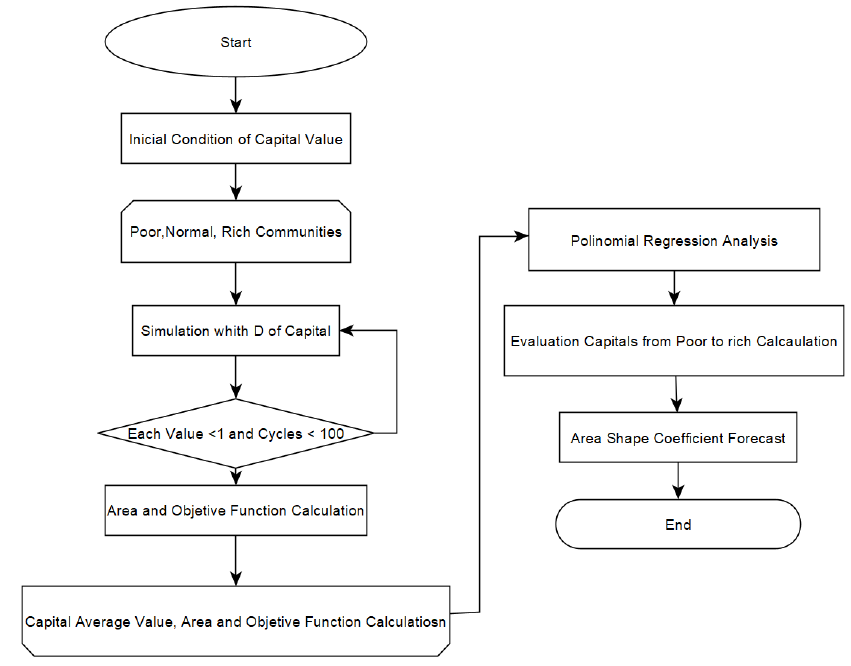
Figure 3. Capitals simulation flowchart.